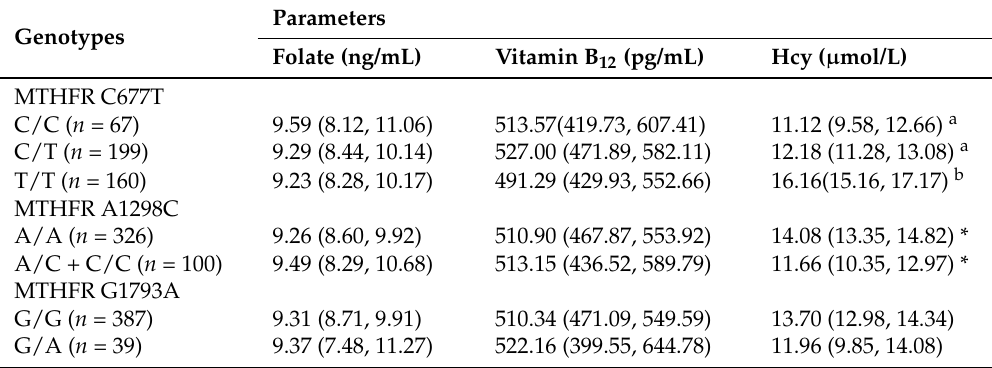
Table 3. Serum folate, vitamin B 12 and Hcy levels according to MTHFR and SLC19A1genotypes ( n =